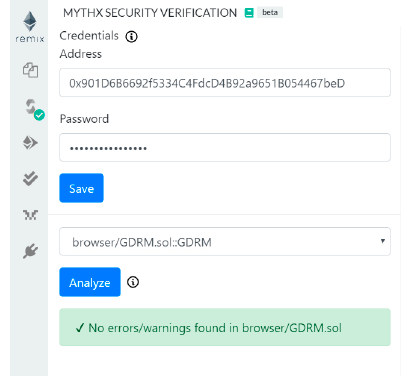
Figure 8. Code vulnerability detection result.